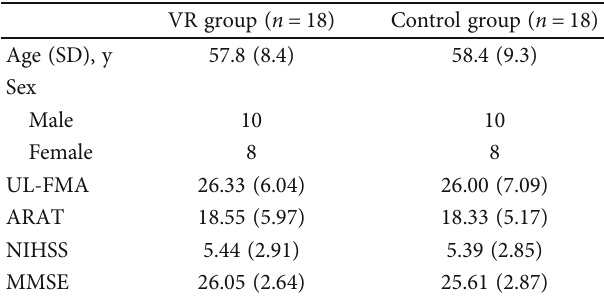
Table 1: Demographics and clinical characteristics of the sample cohorts. UL-FMA: Upper Limb Fugl-Meyer Assessment; ARAT: Action Research Arm Test; NIHSS: National Institutes of Health Stroke Scale; MMSE: Mini-Mental State